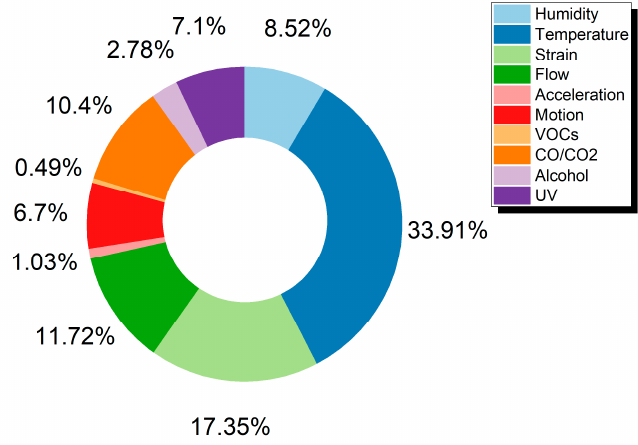
Figure 2. Publications for printed sensors categories between 2013–2020.